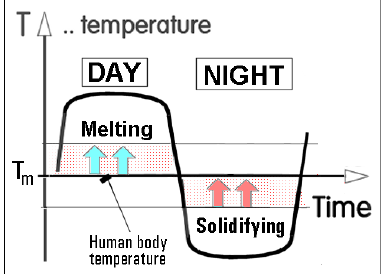
Fig. 5. Although the mutual connection between the system shown in Fig. 2 and the “smart textile” idea in Fig. 4 may be not apparent, the comparison of the time-dependence diagrams Fig. 3 and. 5 shows a certain underlying commonality of the processes.